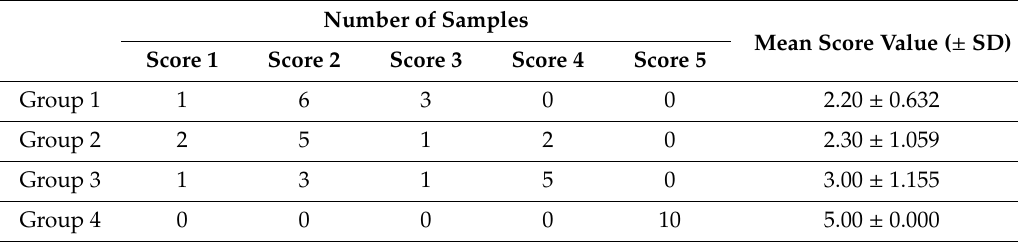
Table 2. The number of samples in the control and study groups scored with values between 1–5 for tubule occlusion.